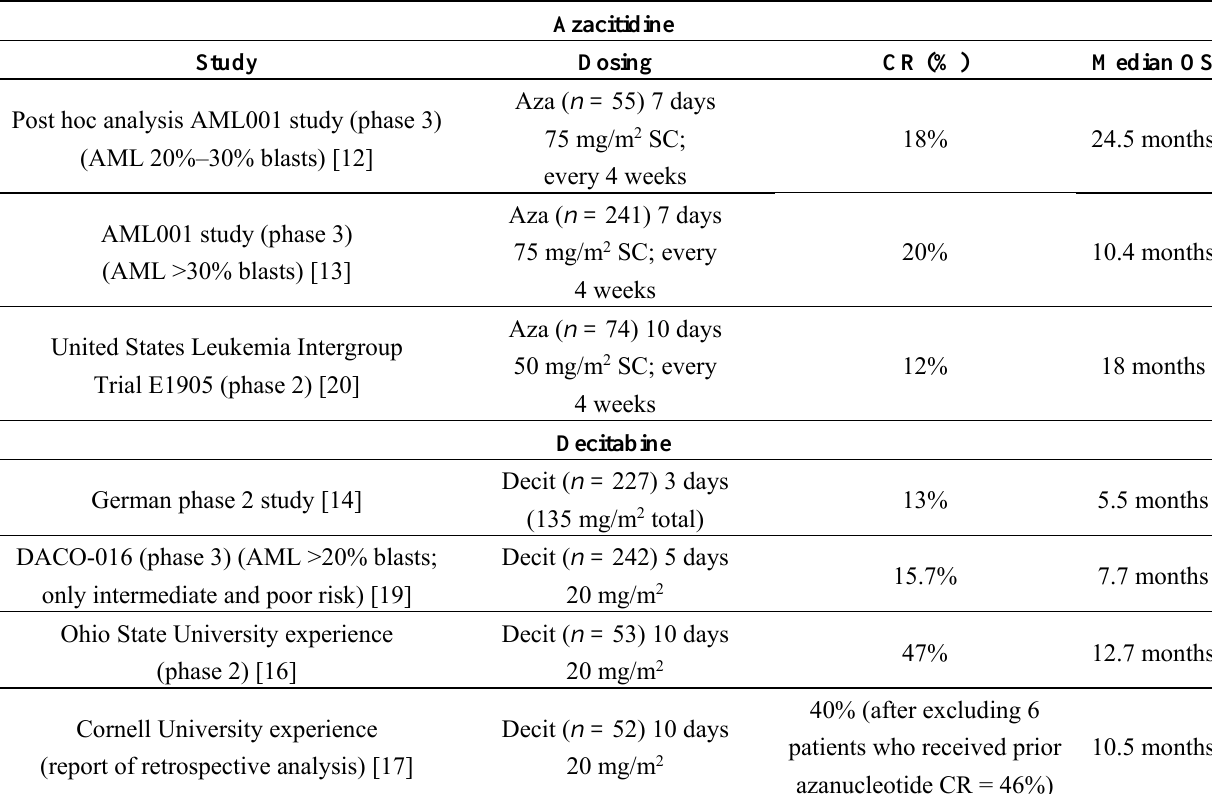
Table 2. Clinical outcome dependent on dosing in